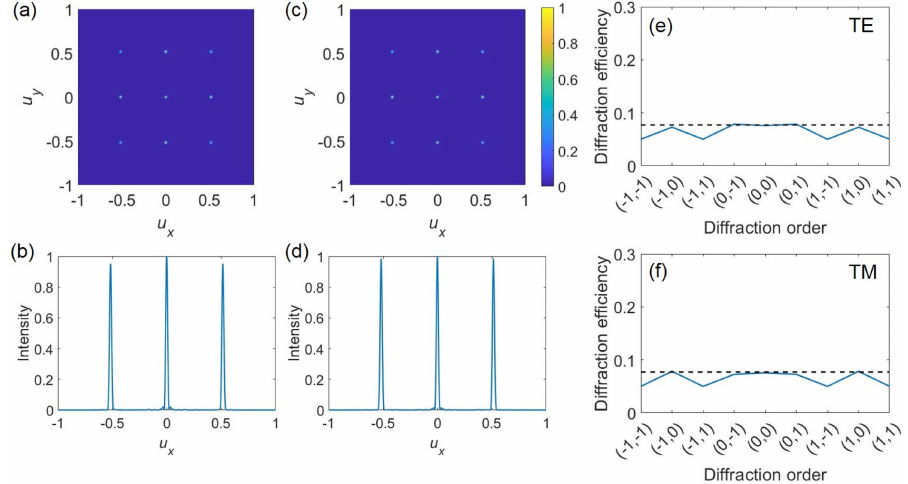
Figure 5. Far-field results of the metafiber-based collimating splitter using FDTD. ( a , b ) Two- dimensional and one-dimensional (when u y = 0) far-field intensity of the collimated Gaussian beam array using designed metasurface under TE polarized incidence. ( c , d ) Two-dimensional and one-dimensional (when u y = 0) far-field intensity of the collimated Gaussian beam array using designed metasurface under TM polarized incidence. ( e , f ) Efficiency extracted from different diffrac- tion orders under TE and TM polarized incidence, respectively. The dashed line is at 0.077 to guide the